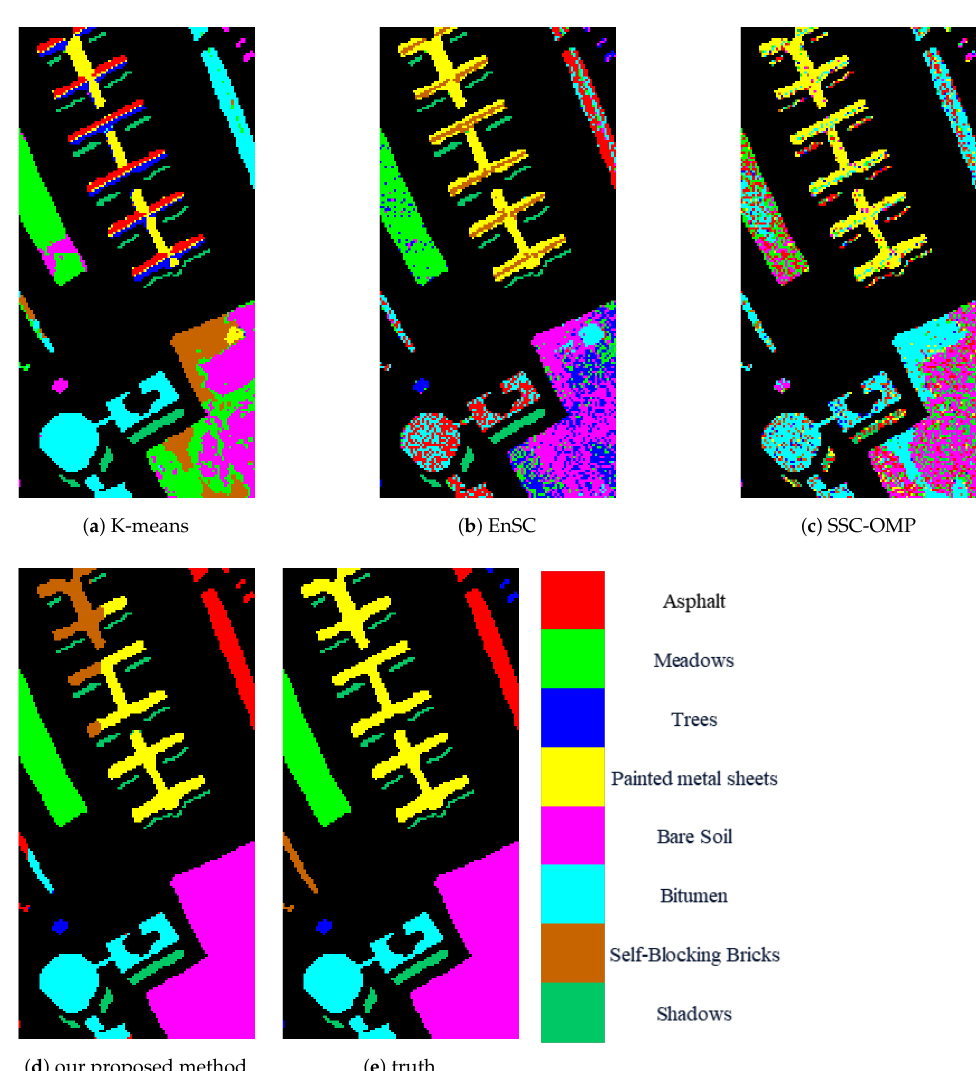
Figure 9. The clustering results of different methods on the Pavia University